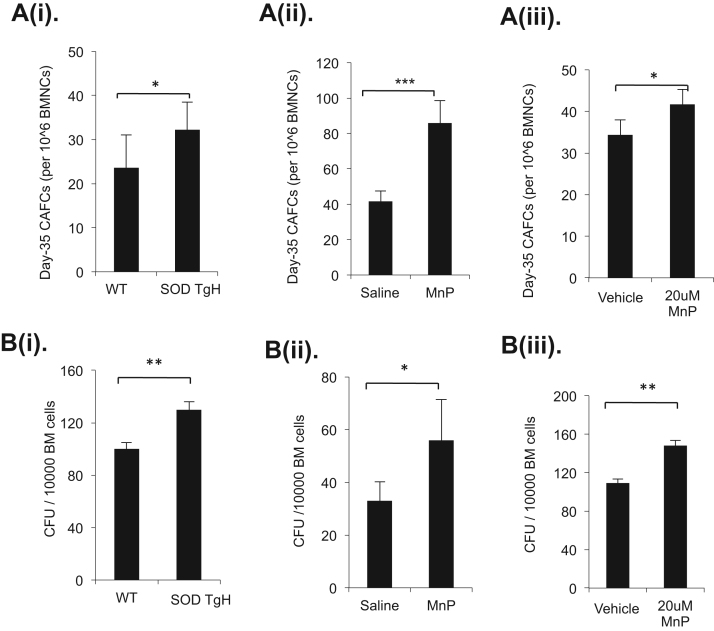
MnP promotes clonogenic function of HSCs and HSPCs. A. The clonogenic function of HSCs was measured at day 35 with CAFC assay. B. The HSPC clonogenic function was determined by counting the total colony forming units per 10,000 BMNCs in CFC assay at day 14. (i) Cells isolated from MnSOD wild- type (WT) and transgenic mice (SOD TgH). (ii) MnP 60-day in vivo treatment. (iii) MnP 16 h in vitro treatment. (n>=3). Data represent the mean+SD of three independent experiments.